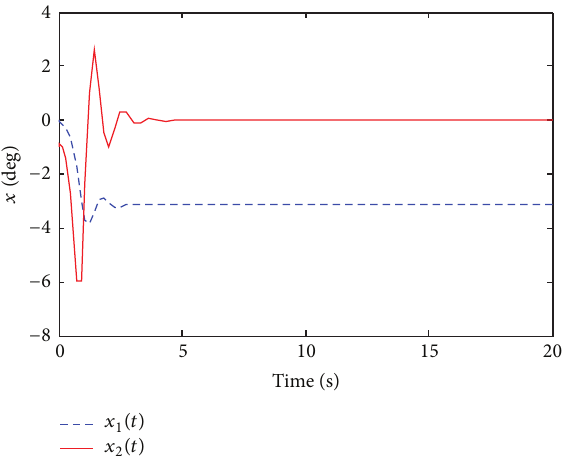
Figure 3: Simulation result without the